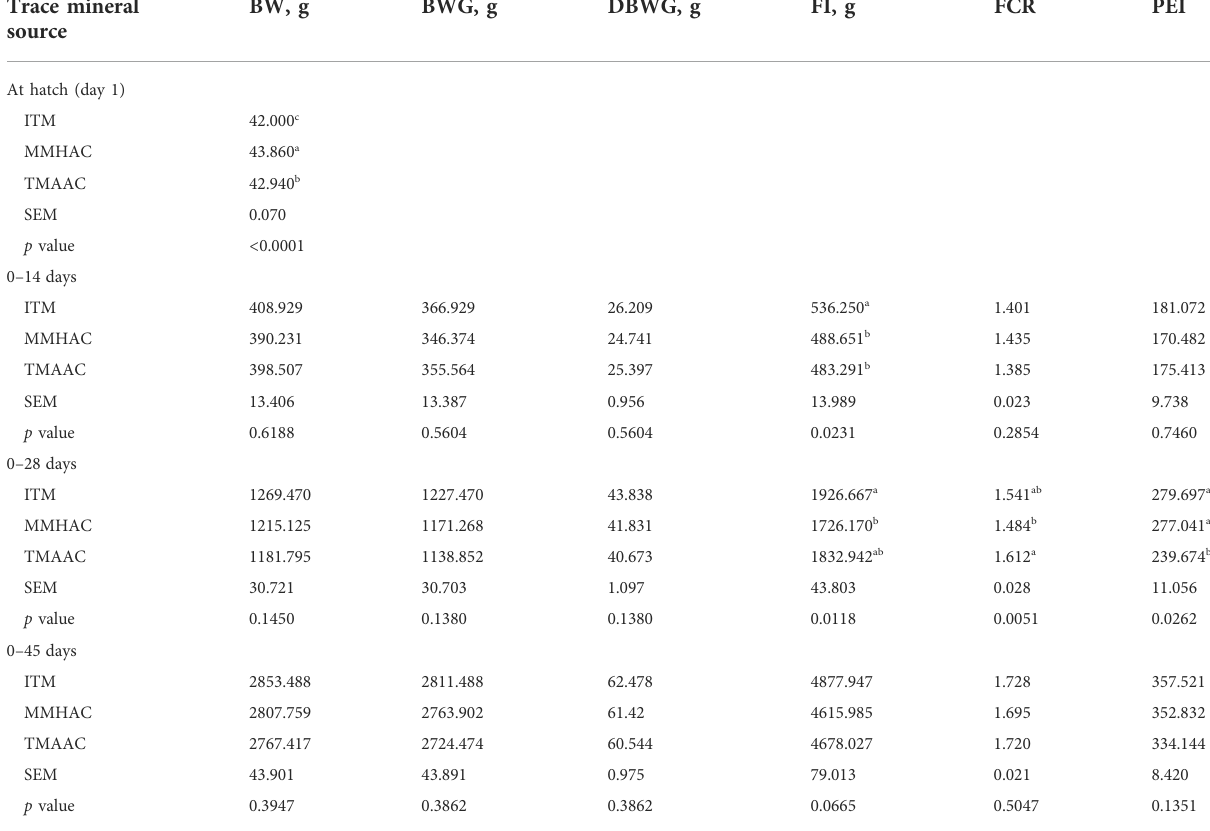
TABLE 9 Effect of inorganic or organic trace minerals on the performance of progeny. Trace mineral